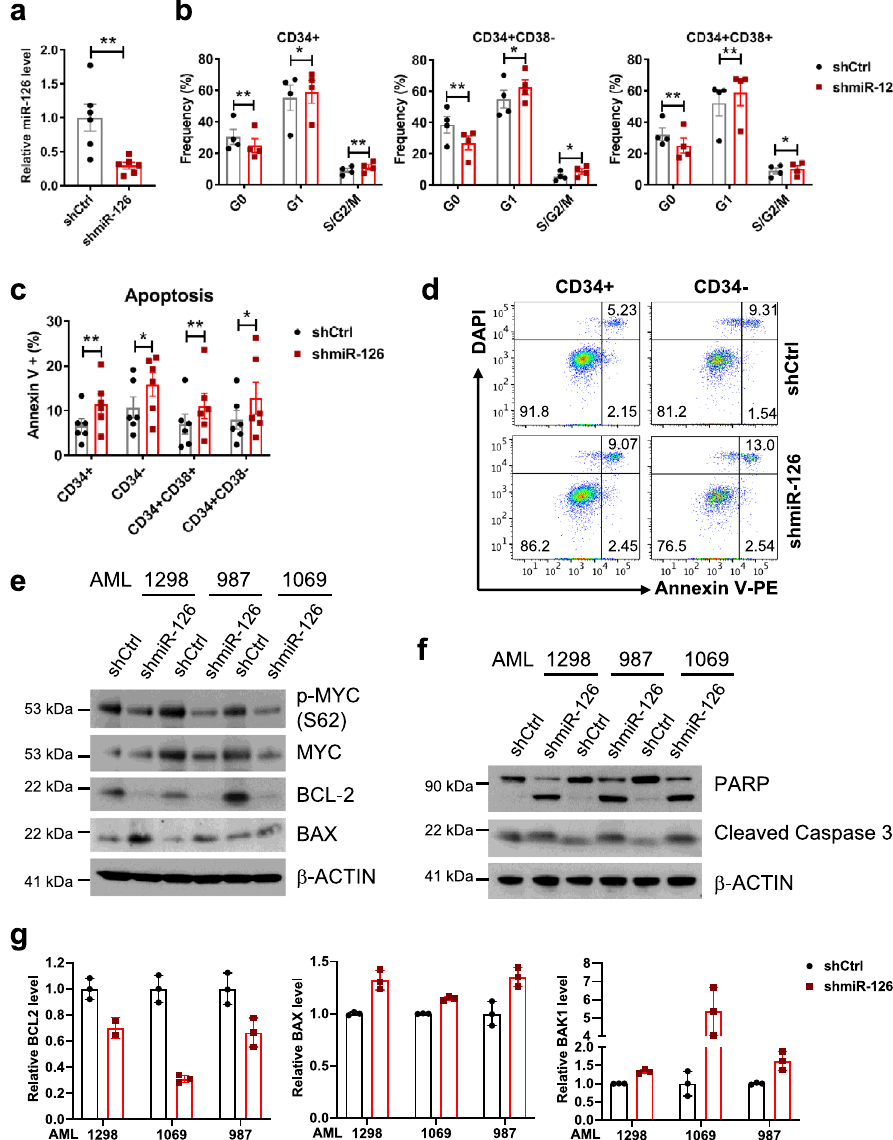
Fig. 5 Knockdown of miR-126 promotes apoptosis and reduces quiescence of primitive inv(16) AML cells. a Relative levels of miR-126 in inv(16) AML CD34 + cells transduced with shCtrl (black) or shmiR-126 (red; p = 0.006), as assessed by qPCR and normalized with internal levels of RNU44. b Frequency (%) of G 0 , G 1 or S/G 2 /M phases of cell cycle in shCtrl (black) or shmiR-126 (red) transduced inv(16) AML CD34 + (G 0 p = 0.0073; G 1 p = 0.046; S/G 2 /M p = 0.0094), CD34 + CD38 − (G 0 p = 0.0069; G 1 p = 0.0184; S/G 2 /M p = 0.0138), and CD34 + CD38 + (G 0 p = 0.0072; G 1 p = 0.0015; S/G 2 /M p = 0.0259) populations. c Frequency (%) of apoptotic cells de fi ned by Annexin V + in shCtrl (black) vs. shmiR-126 (red) transduced inv(16) AML CD34 + ( p = 0.0057), CD34 − ( p = 0.0261), CD34 + CD38 + ( p = 0.0027), and CD34 + CD38 − ( p = 0.0331) populations. d Representative FACS plots showing gating strategy and frequency of Annexin V/DAPI staining in CD34 + and CD34 − fractions of inv(16) AML samples transduced with shCtrl or shmiR-126. e Western blot of p-MYC (S62), MYC, BCL2, BAX in CD34 + cells from inv(16) AML patients (AML1298, 987, 1069) 2 days after transduction with shCtrl or shmiR-126. f Western blot of PARP and Cleaved Caspase 3 in CD34 + cells from inv(16) AML patients (AML1298, 987, 1069) 2 days after transduction of shCtrl or shmiR-126. g Relative levels of BCL2 , BAX , BAK1 in CD34 + cells from inv(16) AML patients (AML#1298, 1069, 987) transduced with shCtrl (black) or shmiR-126 (red), as assessed by qPCR and normalized using internal levels of B2M . Data are presented as the mean ± SD. Two-way ANOVA showed p < 0.0001 for BCL2 ; p < 0.0001 for BAX , and p = 0.006 for BAK1 . In a – c, each dot represents result from an individual patient and data are presented as the mean ± SEM; statistical signi fi cance shown was determined using two-tailed Student ’ s T tests (* p < 0.05; ** p < 0.01; *** p < 0.001). Representative of two independent experiments with similar results are shown in e , f